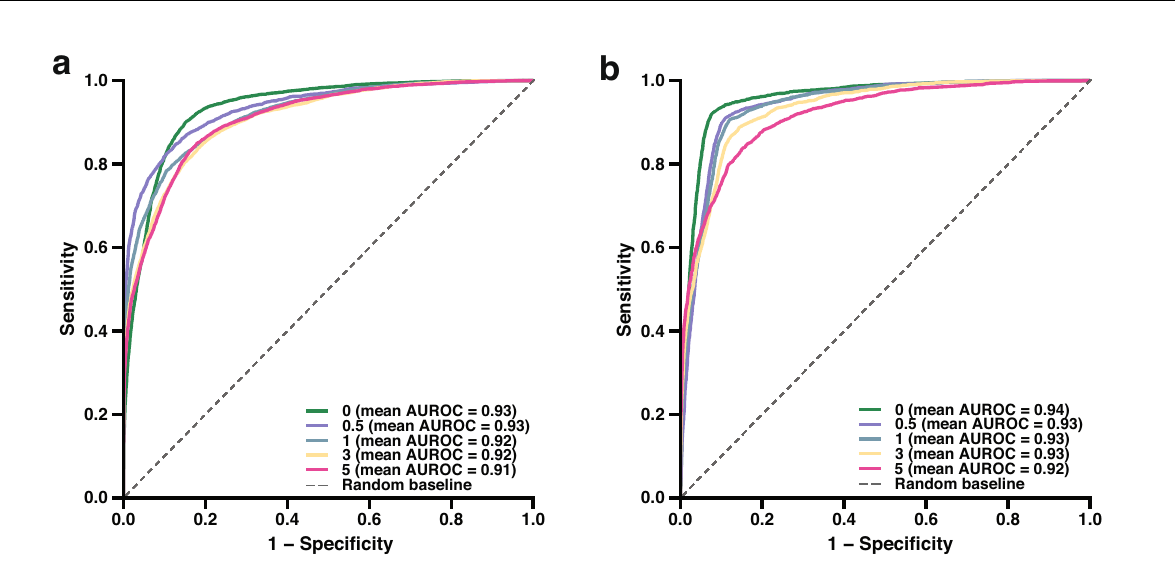
Fig. 4 | Prediction of future autoantibody and rheumatological testing. a , b AUROCs of models to predict autoantibody testing and rheumatologist encounter up to 5 years in advance of testing or encounter date, respectively.